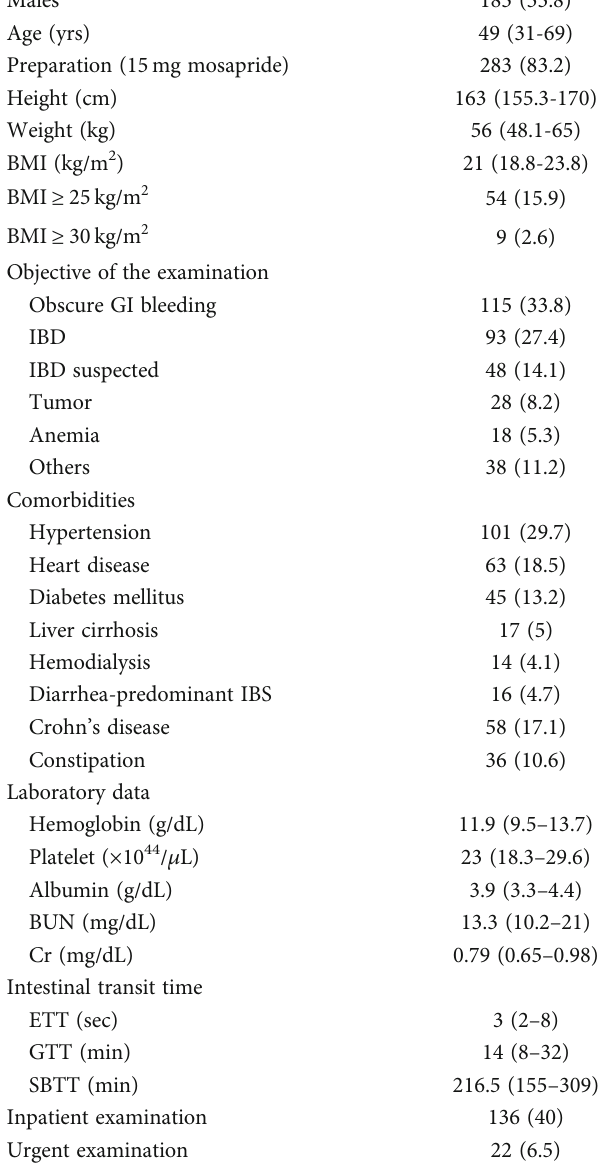
Table 1: The patients ’ characteristics ( n = 340